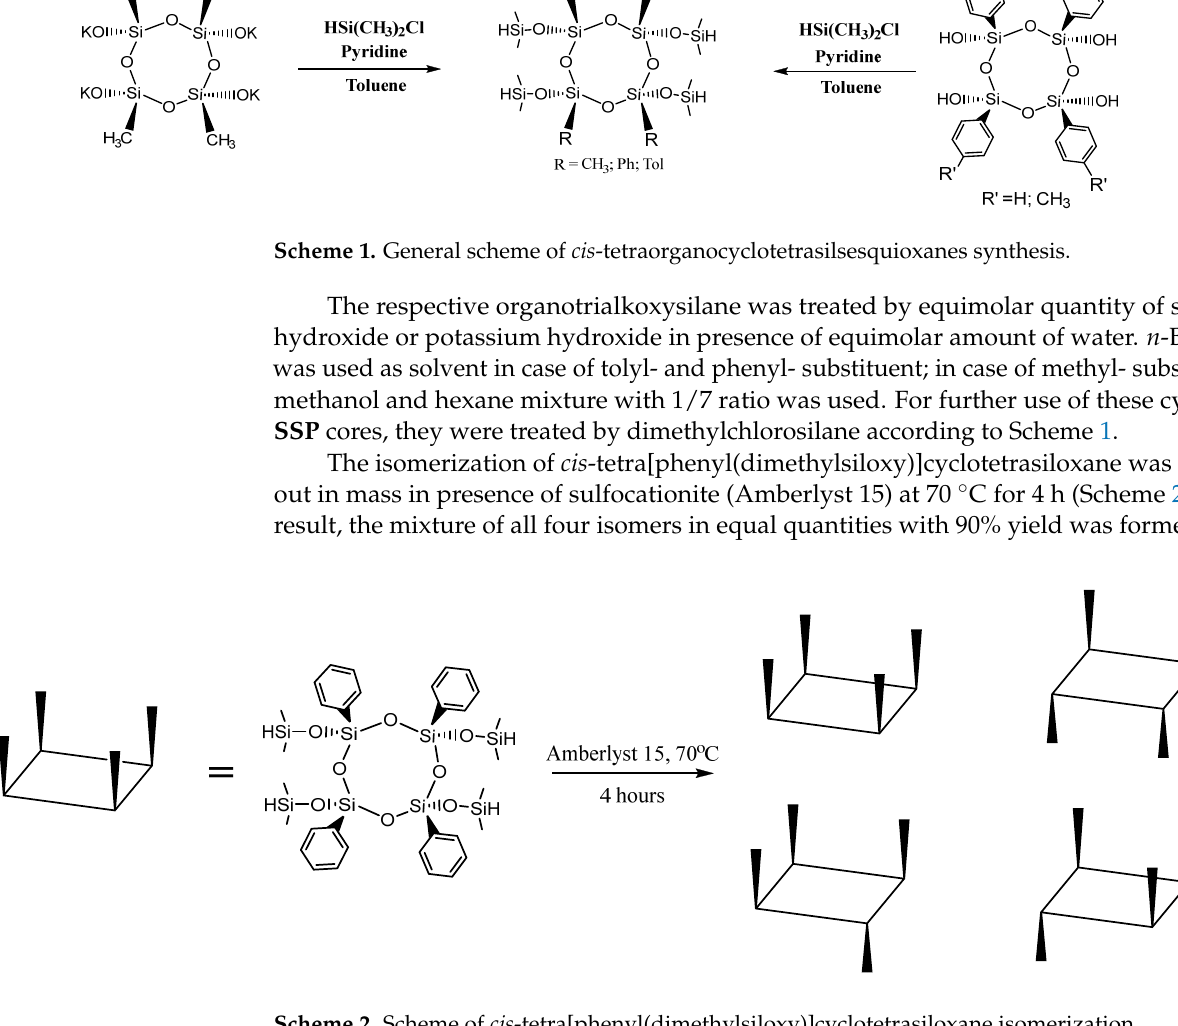
Figure 1. 1 H NMR-spectra of initial compound (violet), after 1 h from the beginning of reaction (tur- quoise), after 2 h (green) and after 4 h (burgundy). Reaction mass samples were taken after 1, 2, and 4 h from the beginning of reaction. According to the 1 H NMR spectroscopy data of initial compound, cis- tetra[phenyl (dimethylsiloxy)]cyclotetrasiloxane (a violet curve), in the field of 4.9 ppm we observe a signal that corresponds to SiH-group. As isomerization goes on, the emergence of new signals in the field of 4.5–5 ppm (turquoise and green curves), which correspond to SiH isomers groups is observed. The appearance of signals of equal intensity for all SiHgroups in the region of 4.5–5 ppm (burgundy curve) shows the moment when the reaction ends. The isomerization reaction is completely over (stopped) 4 h after the start.